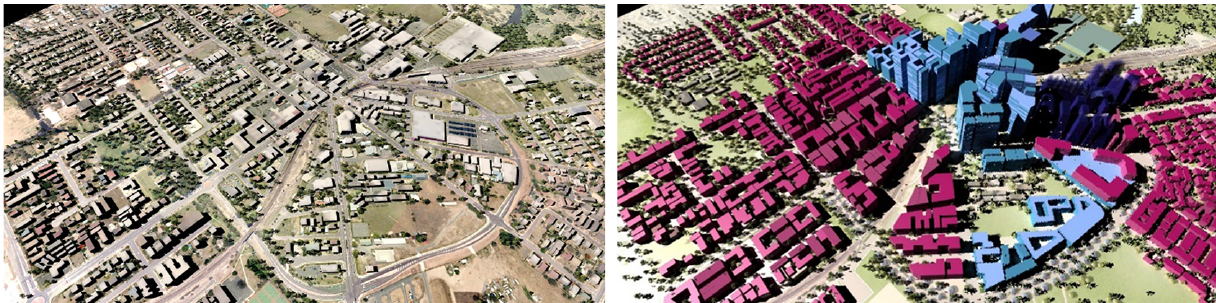
Figure 13. Left image shows render of 3D digital model of existing urban form. Right image shows render of flexible 3D dig- ital model of master plan’s potential urban form, used for visualisation; communication; solar impact analysis; and design advocacy.